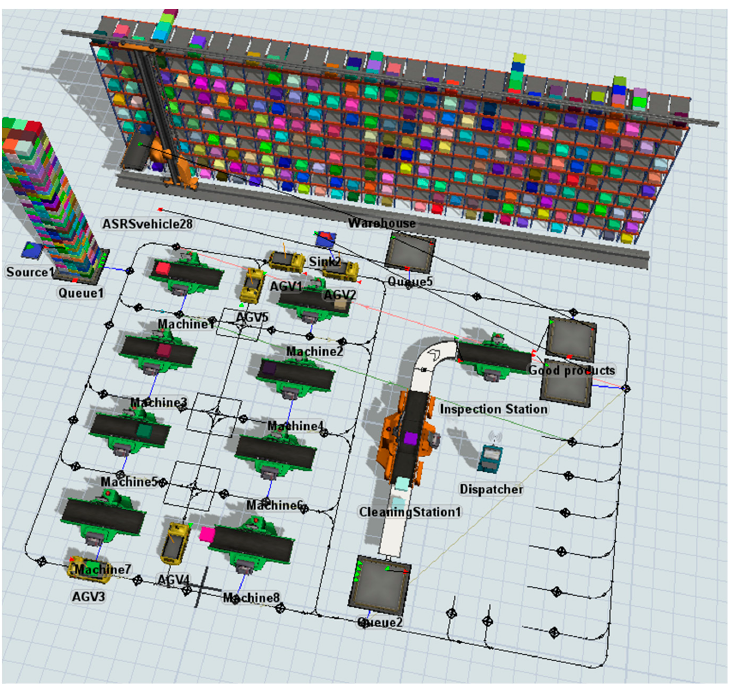
Figure 3. Simulation model of the FMS with AGV transport.